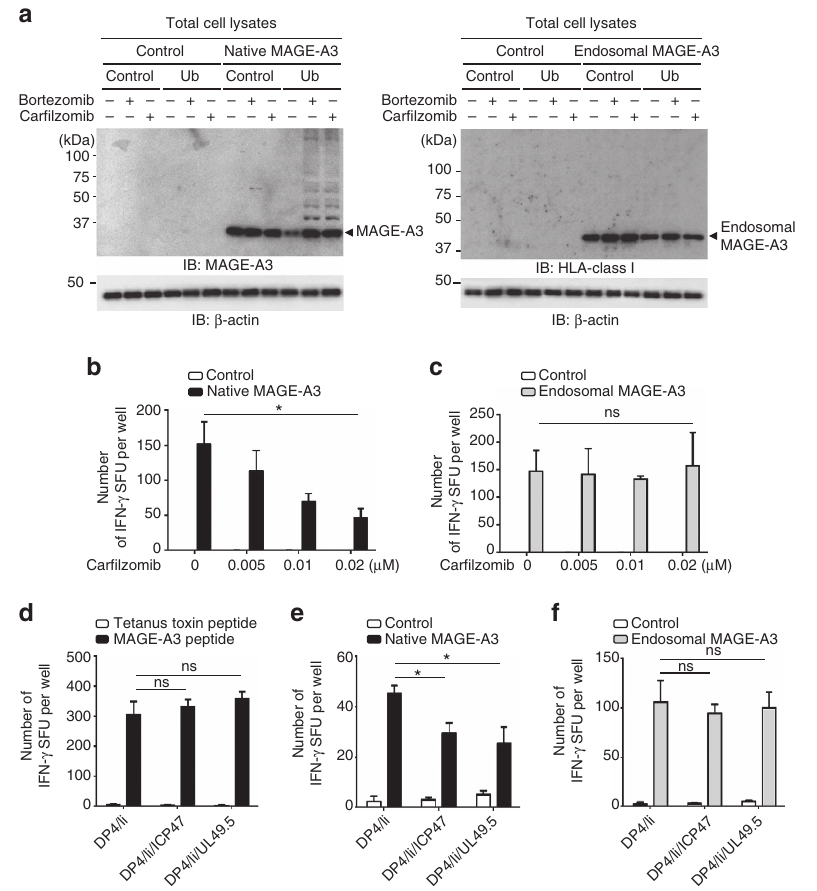
Figure 6 | DP 84GGPM87 -expressing cells constitutively present intracellular peptides generated by the proteasome and TAP-dependent pathway. ( a ) K562 aAPCs were transiently transfected with the indicated combinations of genes and cultured in the presence or absence of 0.02 m M bortezomib or 0.02 m M carfilzomib for 48h. Total cell lysates were immunoblotted with anti-MAGE-A3, anti-HLA-class I or anti- b -actin mAb. ( b , c ) K562/DP4/Ii cells were transiently transfected with a retrovirus vector encoding IRES-EGFP (control), or a native ( b ) or endosome-targeted ( c ) form of MAGE-A3 linked with IRES-EGFP. Cells were then cultured with carfilzomib at the indicated concentrations for 48h. Transient transfection efficiencies were normalized to EGFP expression measured by flow cytometry. DP4/MAGE-A3 243–258 CD4 þ T cells were stimulated with the K562/DP4/Ii transfectants and IFN- g secretion was measured by ELISPOTanalysis. Data shown represent means ± s.d.’s of triplicates. ( d ) DP4/MAGE-A3 243–258 CD4 þ Tcells were stimulated with the indicated K562-based aAPCs pulsed with tetanus toxin 947–967 (control) or MAGE-A3 243–258 peptide, and IFN- g secretion was evaluated by ELISPOTassays. Data shown represent means ± s.d.’s of triplicates. ( e , f ) The indicated K562-based aAPCs were transiently transfected with a retrovirus vector encoding IRES-EGFP (control) or a native ( e ) or endosome-targeted ( f ) form of MAGE-A3 linked with IRES-EGFP. Transient transfection efficiencies were normalized to EGFP expression measured by flow cytometry. DP4/MAGE-A3 243–258 CD4 þ T cells were stimulated with the indicated aAPCs and IFN- g secretion was measured by ELISPOT analysis. Data shown represent means ± s.d.’s of triplicates. Results are representative of three independent experiments. ns, not significant; * P o 0.05 by unpaired, two-tailed Welch’s t